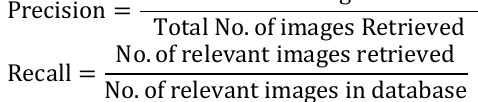
Figure 10. Precision versus Recall graph of Corel-1K